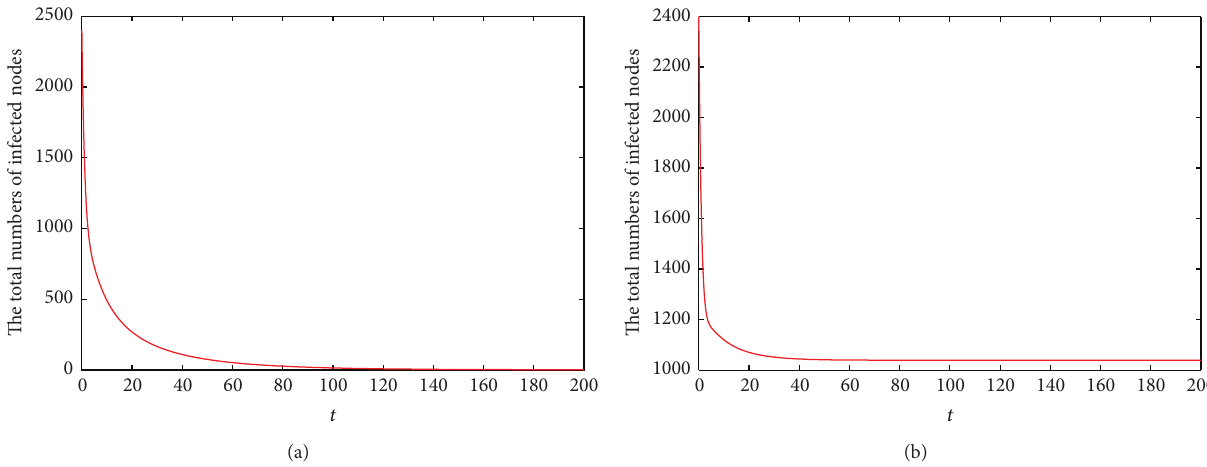
Figure 3: The total number of infected nodes on BA networks. We set parameters 𝑀 = 4 , 𝑞 1 = 0.1 , 𝑞 2 = 0.2 , 𝑞 3 = 0.3 , and 𝑞 4 = 0.4 ; that is, ⟨𝑖⟩ = 3 and 𝛽 = 0.037 or 𝛽 = 0.047 , which corresponds to 𝑅